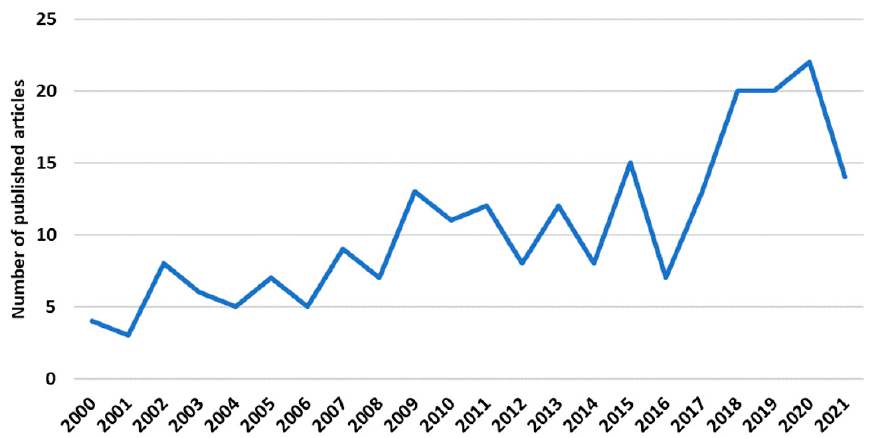
Figure 4. The annual number of articles published related to suburban fires. Data retrieved from Web of Science [32] for dates between 2000 and 2021.